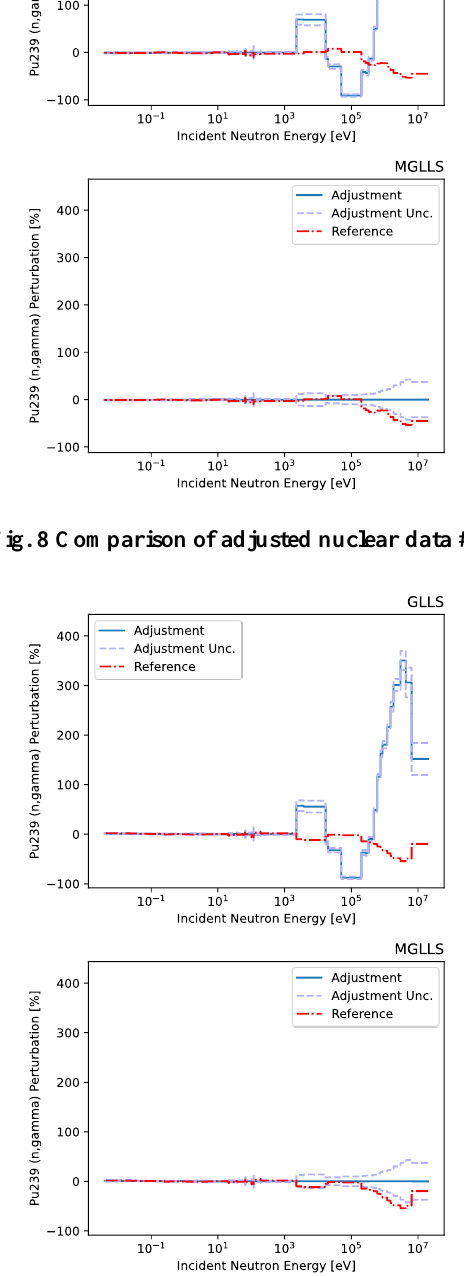
Fig. 9 Comparison of adjusted nuclear data #8